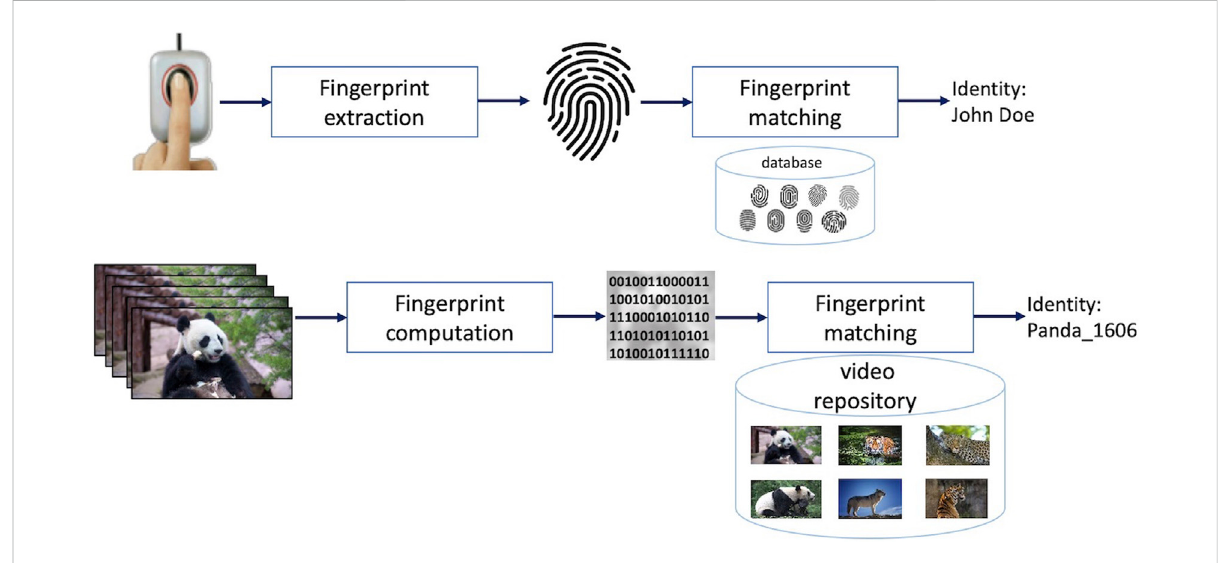
FIGURE 1 Human fi ngerprinting versus video fi